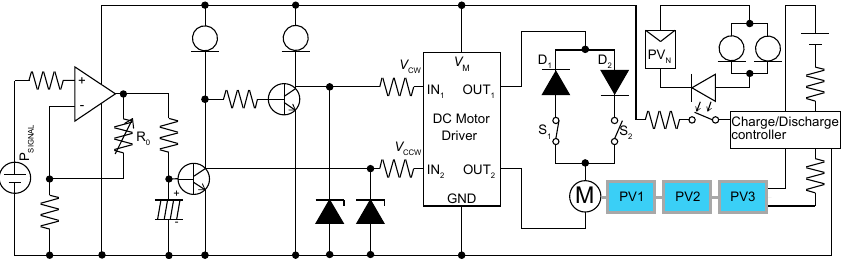
Figure 3. PV blind (PV 1 –PV 3 ) control circuit: P SIGNAL transforms the horizontal global irradiance into voltage. A variable resistor R 0 sets a threshold irradiance level for blind rotations. An additional PV